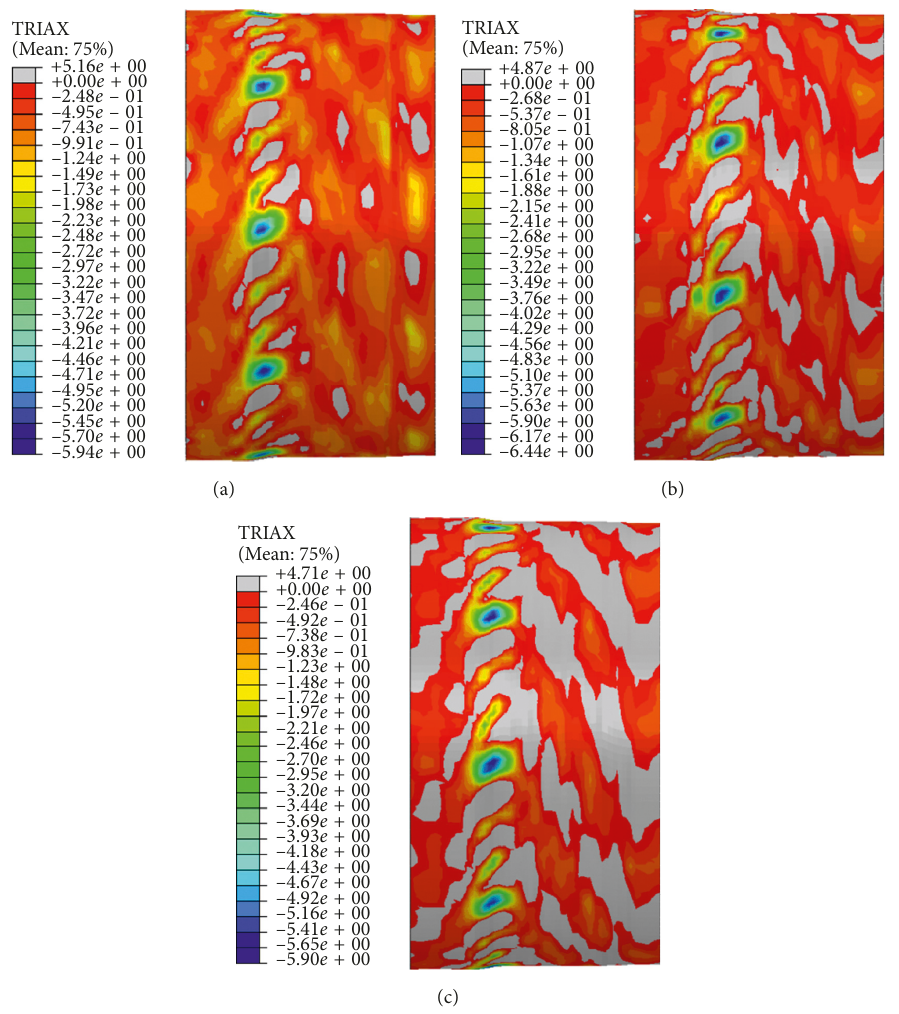
Figure 6: Cloud diagram of relative stress triaxiality for different ball diameters. (a) R